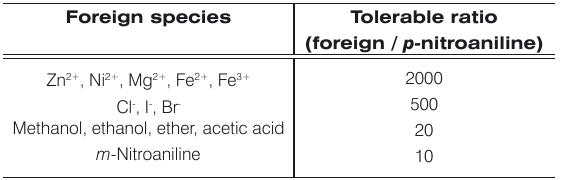
Table 1. The influence of foreign species on the determination of p- nitroaniline ([ p- nitroaniline]=1.0 × 10 -5 mol L -1 ).